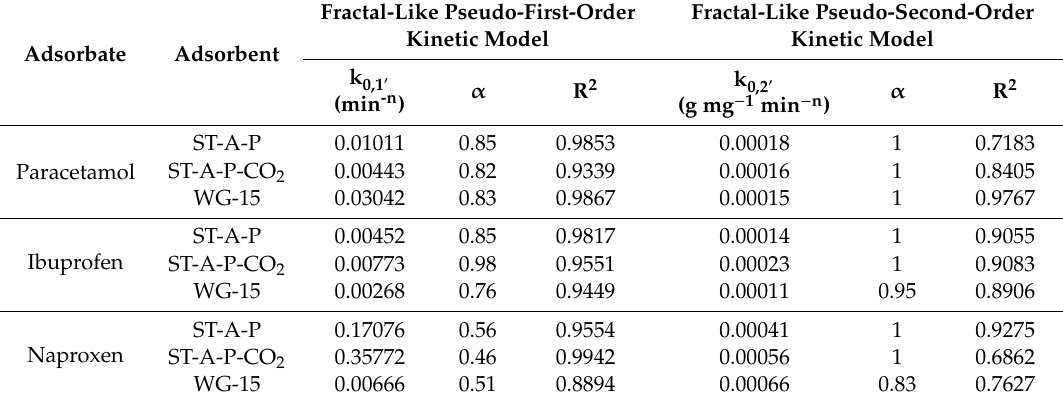
Table 6. Kinetic parameters of paracetamol and NSAIDs adsorption on the studied adsorbents.